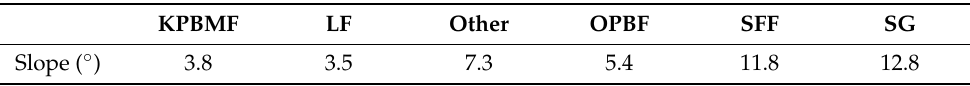
Figure 8. Box − and − whisker plot of Tree Species Slope Distribution. Table 4. Average slope of tree species in Changbai Mountain Protection Development Zone.